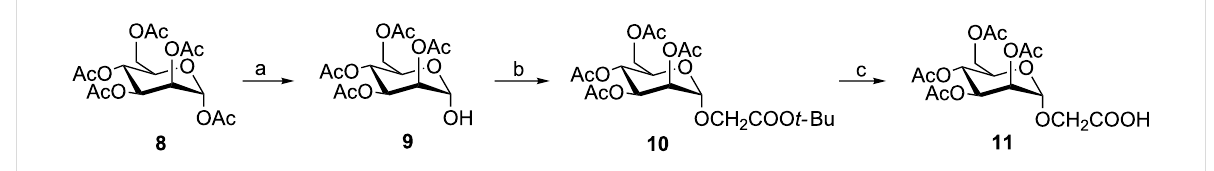
Scheme 3: Synthesis of the mannose precursor. Reagents and conditions: a) Zn(OAc) 2 ·H 2 O, abs. MeOH, rt, 20 h, 60%; b) BrCH 2 COOC(CH 3 ) 3 , K